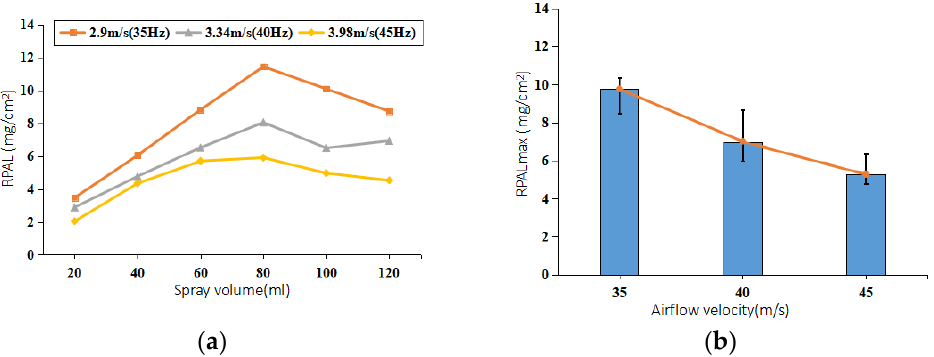
Figure 9. Effect of airflow velocity on RPAL: ( a ) RPAL against spray volume under different airflow velocity; ( b ) relationship between airflow velocity and RPAL max .